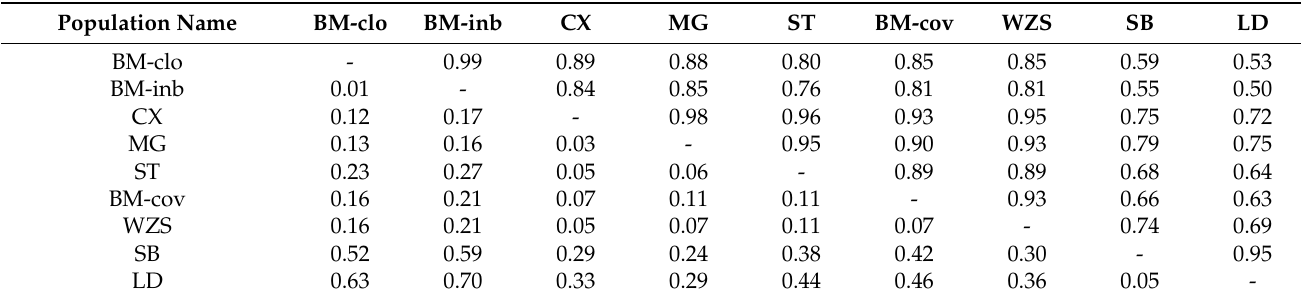
Table 3. Nei’s unbiased measures of genetic identity and genetic distance generated by the 30 SINE RIPs in eight pig